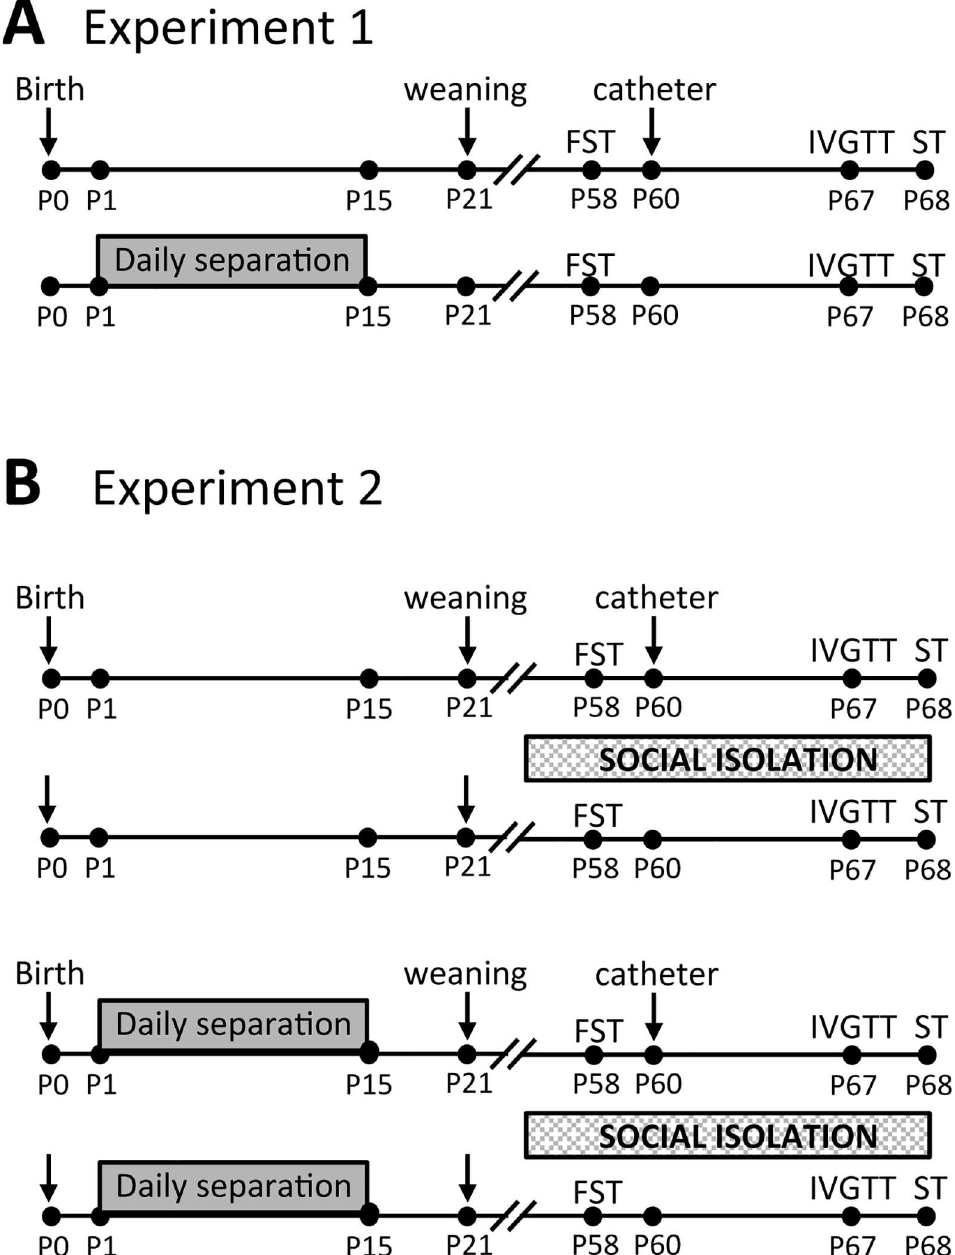
Fig 1. Experimentaldesign. A) To characterize the effect of maternalseparation(MS180)on metabolicrisk and its relationto HPA axis activity, pups were weaned at P21 and group houseduntil adulthood.B) In orderto evaluate whethersocial isolationrearing(SIR)increases MS180-related effects, half the animalswere randomly assignedto SIR (singlehousing) or standardgroup housing(AFR)at weaning.All animalswere subjectedto the forced swimming test (FST)at postnatalday 58 (P58).All groups were catheterized on P60 and subjectedto the intravenous glucose tolerancetest (IVGTT) on P67. HPA axis stress responsivityaftera 2 min cold swim stress (ST)was evaluated on